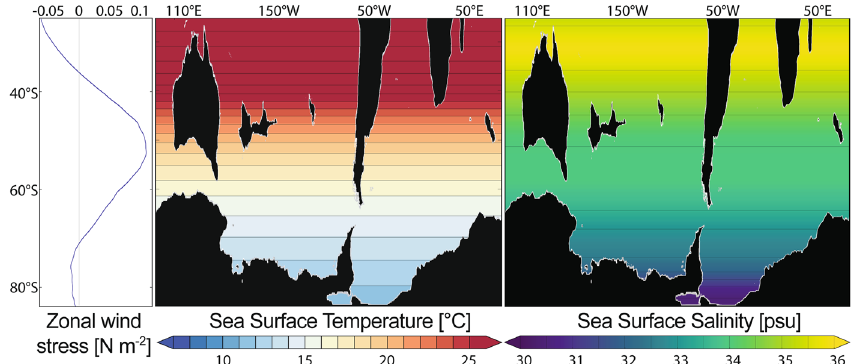
Fig. 4 Restoring boundary conditions. Con fi guration of atmospheric forcing used in this model: stationary zonal wind stress (left), sea surface temperature (centre) and sea surface salinity (right); derived from a coupled ocean-atmosphere model simulation with atmospheric CO 2 concentration of 800ppm 28 , zonally and annually